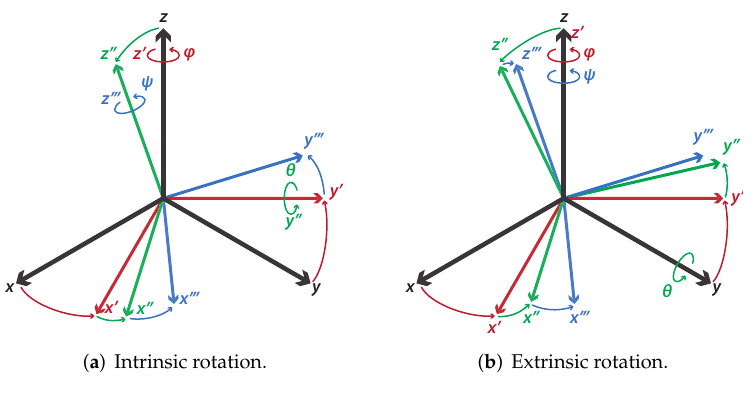
Figure 4. Kinds of